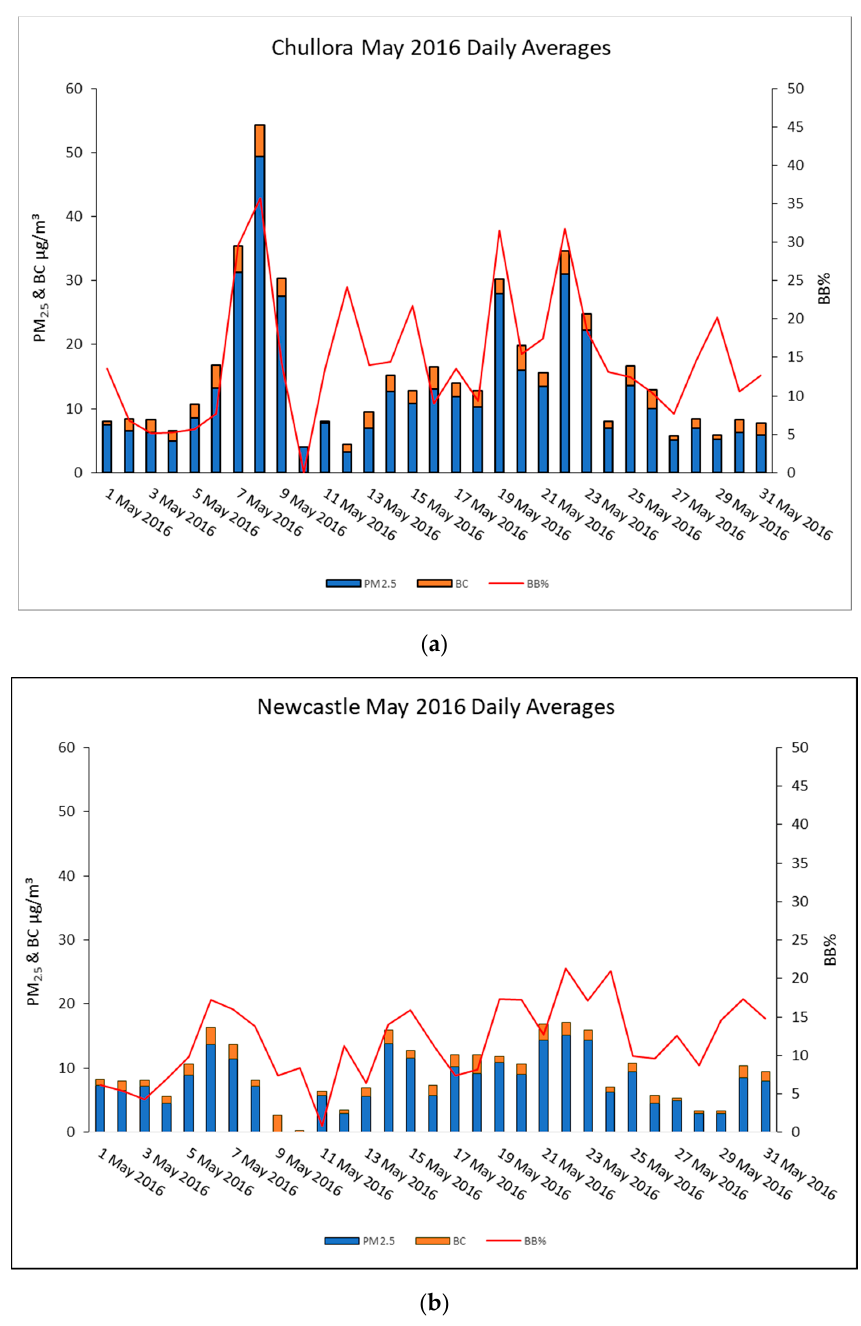
Figure 11. Daily average of PM 2.5 , BC and Biomass Burning ratio (BB) for May 2016: ( a ) at Chullora; and ( b ) at Newcastle. The BC values are stacked on the PM 2.5 ones in the column graph. Figure 12a,b shows the regression of BC with PM 2.5 at Chullora and Newcastle. The daily average time series of PM 2.5 , BC and BC/PM 2.5 (and its trend line) at Chullora and Newcastle are shown in Figure 12c,d. The dotted vertical lines are the ± σ (standard deviation of intraday hourly variation on the day) from the daily mean. There is a significant variation of hourly BC/PM 2.5 during the 24-h period in each day. In the previous study [42] of BC at Newcastle for the period from 10 December 2015 to 25 May 2017, the average BC/PM 2.5 was reported at about 10% and could reach up to 30% in autumn–winter. For the May 2016 period, Figure 12d shows the ratio varies between 5% and 30%, which is in line with the previous study [42].